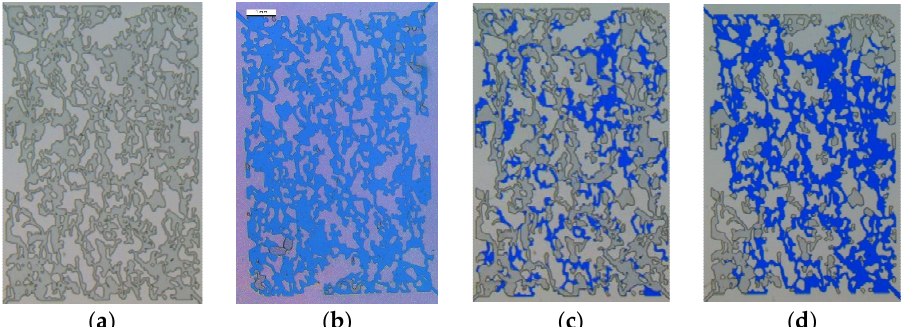
Figure 20. Evaluation of the effect of nano-emulsion in removing water blocking damage in 50 μ m model. ( a ) The model before liquid-saturated; ( b ) The chip saturated with nano-emulsion fluid; ( c ) The chip after gas drive saturated brine under 500 mbar; ( d ) The chip resaturated aqueous phase under 500 mbar.